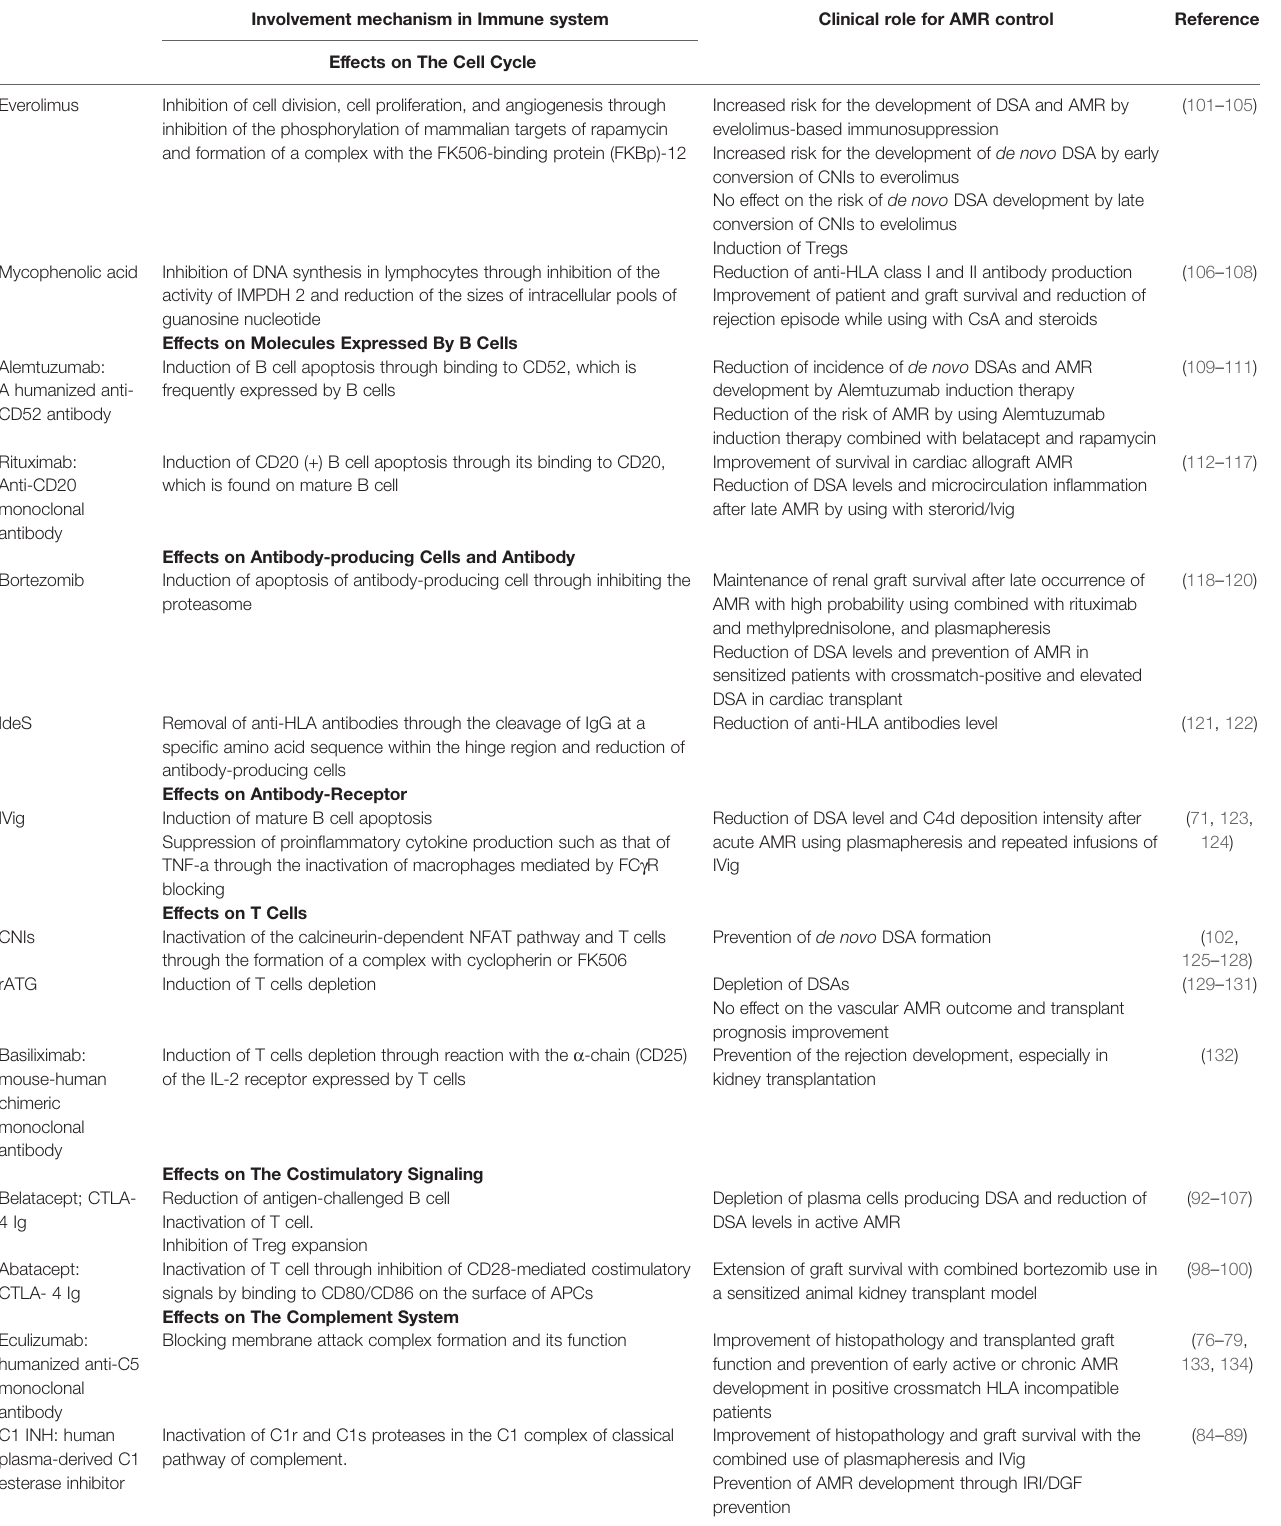
TABLE 1 | Effects of immunosuppressive therapy on the immune system and its clinical role in AMR